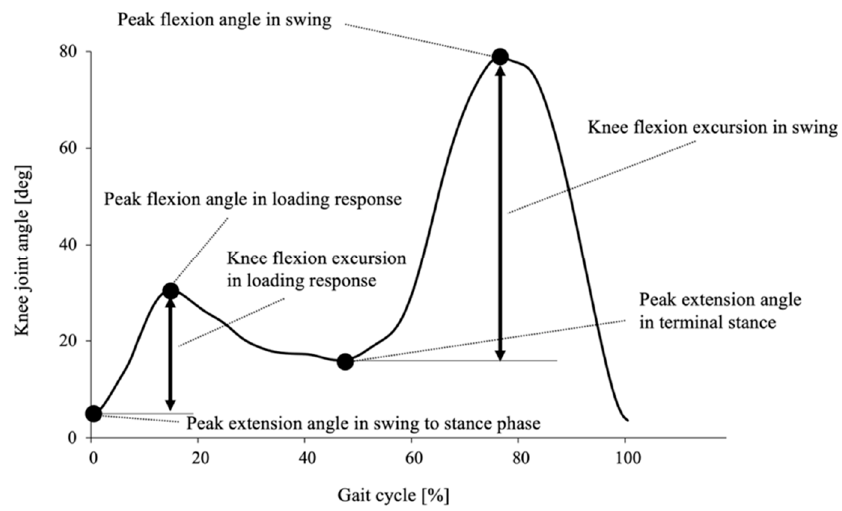
Figure 1. Typical knee flexion angle of a subject in one gait cycle. The knee flexion excursions were calculated from the amplitude of displacement from the peak extension angle to the peak flexion angle during the loading response and swing phase.